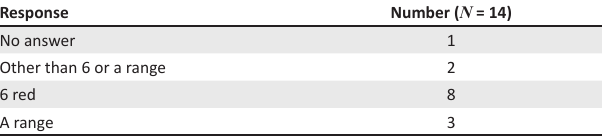
TABLE 1: Responses to Question 1: Expected number of reds.